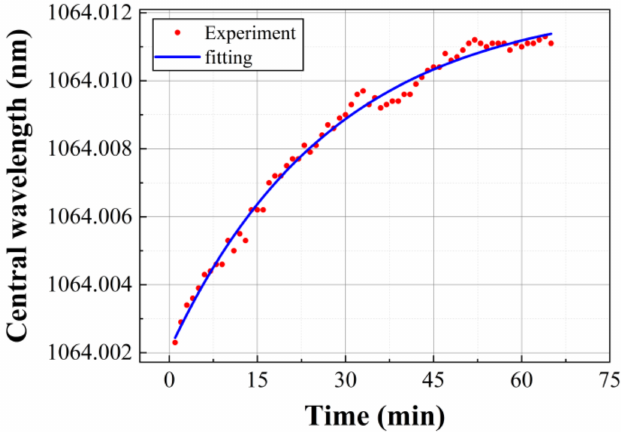
Figure 7. Schematic diagram of central wavelength